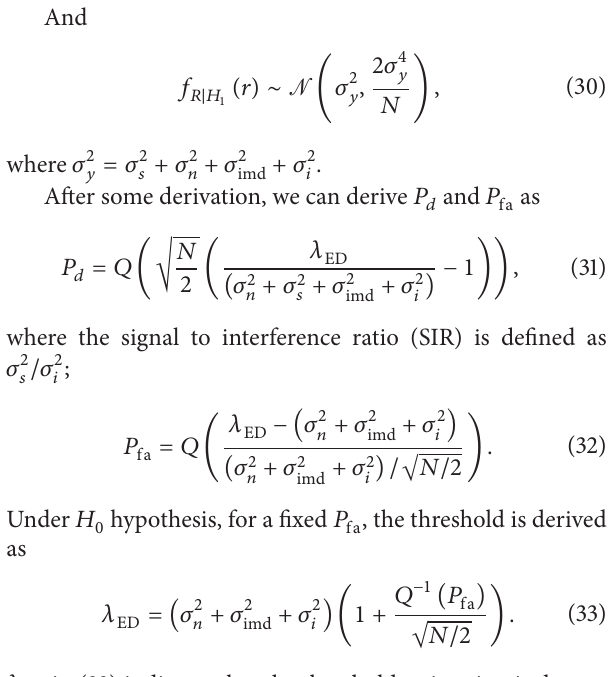
Figure 7: 𝑃 𝑑 versus 𝑃 fa .